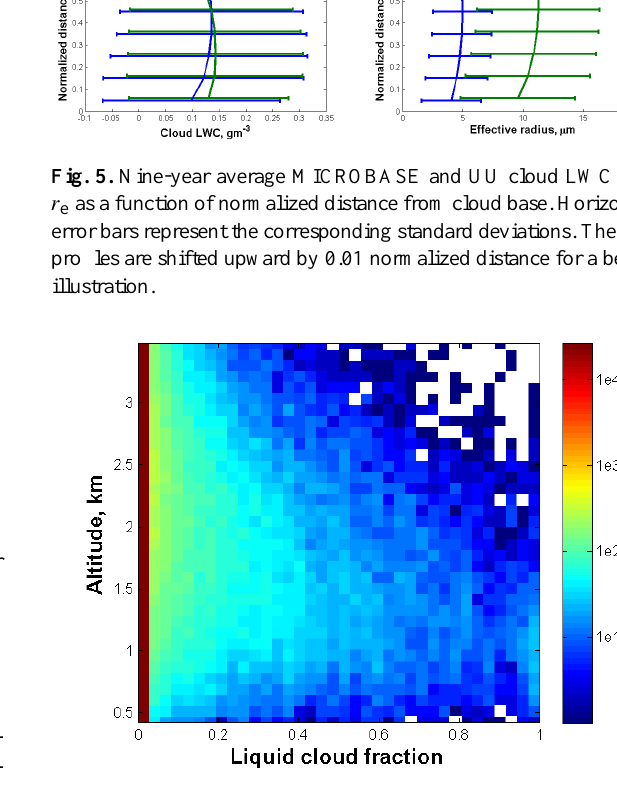
Fig. 6. CFAD of cloud fraction for non-raining non-mixed-phase low-level stratus from the University of North Dakota (UND) prod- uct at the SGP site from 1998 to